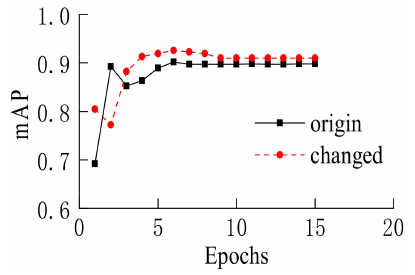
Figure 15. mAP of 0.5IoU.